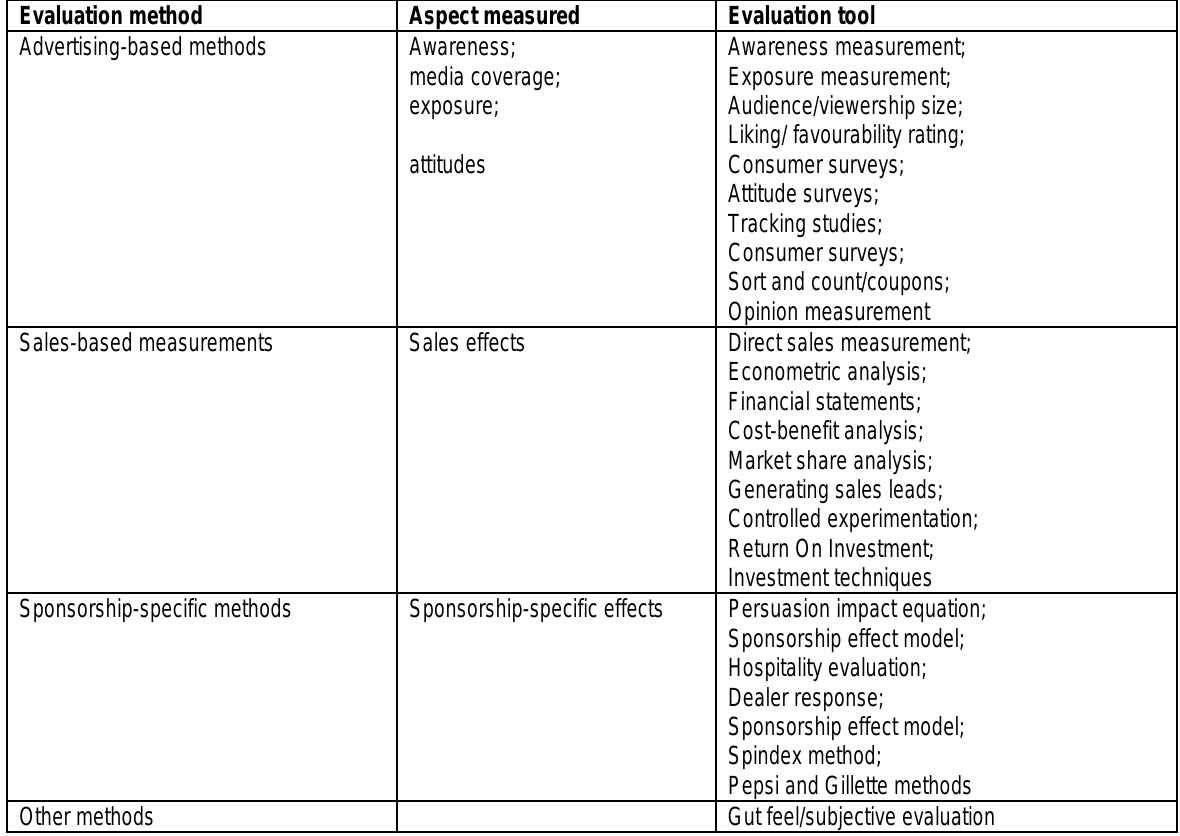
Table 2: The more important evaluation tools for sponsorships Evaluation method Aspect measured Advertising-based